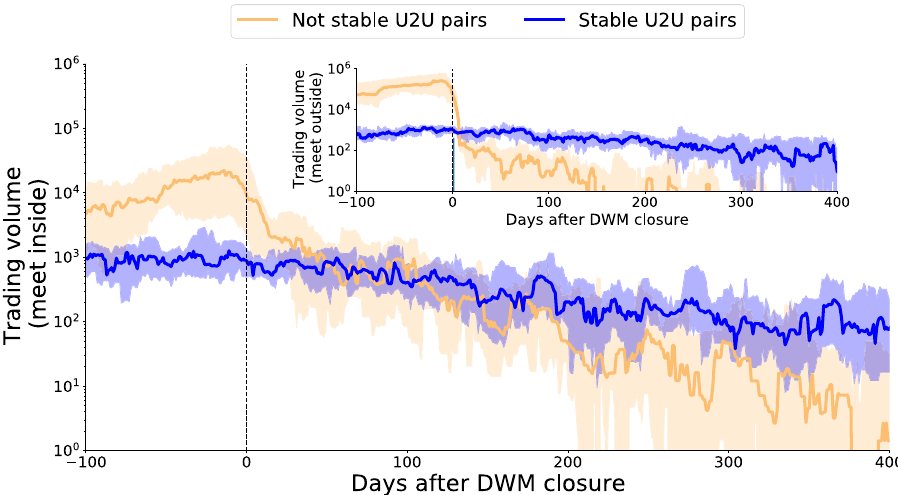
Figure 4. Resilience of stable U2U pairs after DWMs closure. Trading volume of U2U pairs surrounding active DWMs. (Main) U2U pairs meet who met inside aa DWM. (Inset) U2U pairs meet outside them. Plotted lines indicate the median value while bands represent the 95% confidence interval. Day zero corresponds to the day when the DWM closed. Negative and positive numbers indicate the days prior and after the closure, respectively. Only the 33 DWMs that closed during our time period are considered in the analysis.